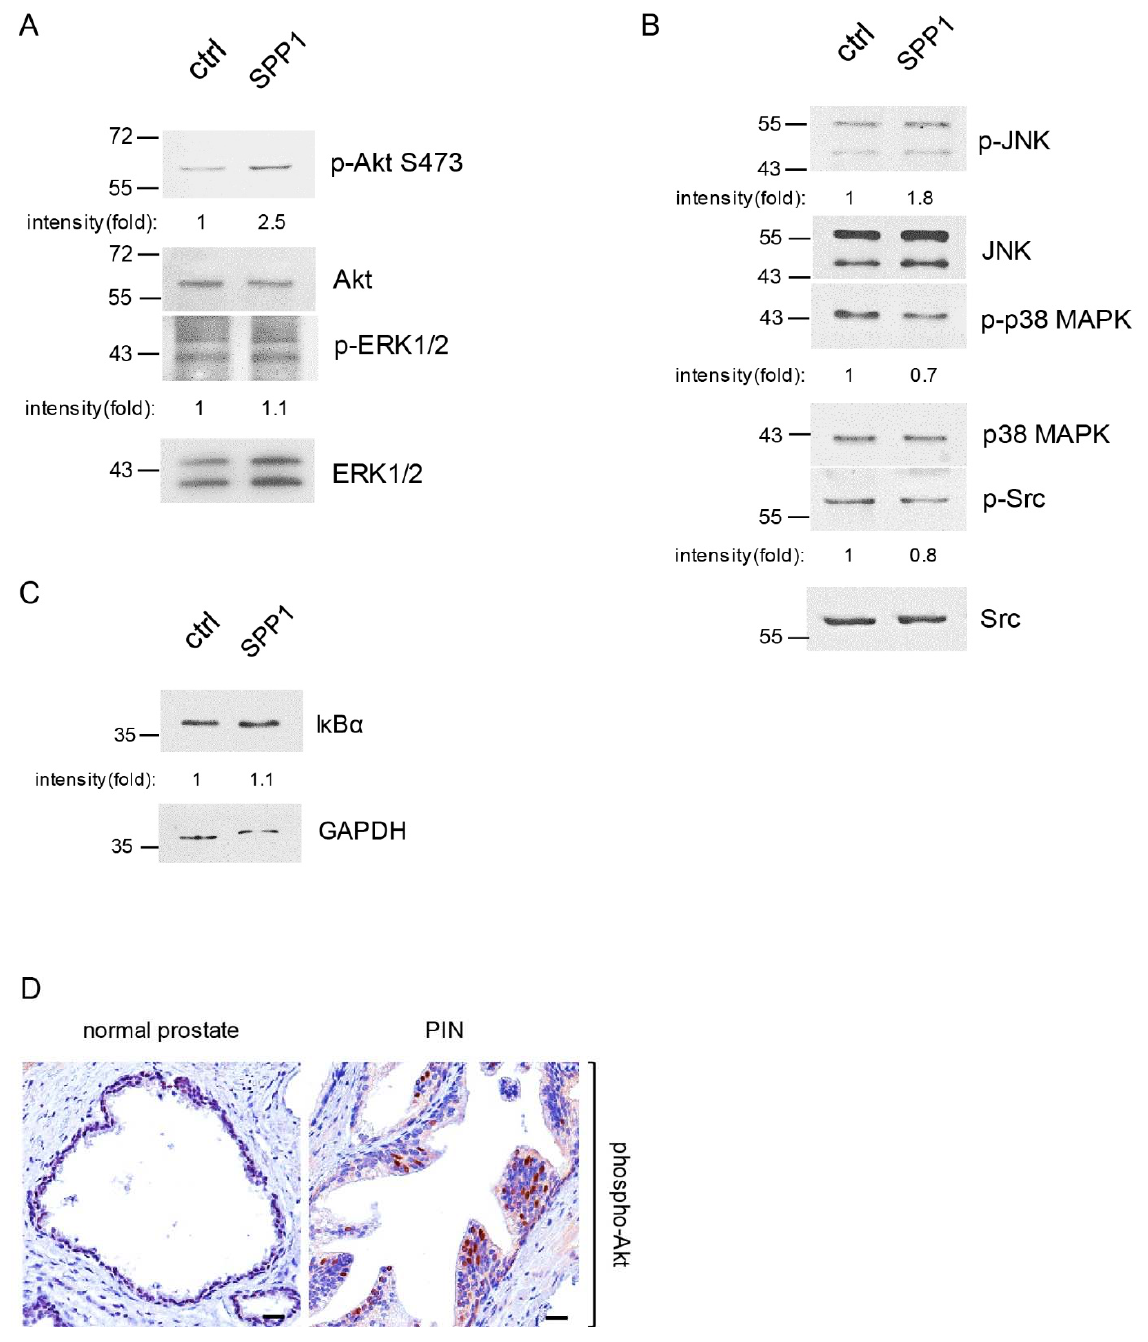
Figure 4. Macrophage Spp1 activated Akt and JNK signaling in PIN cells. ( A – C ) Pr111 cells cultured on Matrigel in 3D were stimulated with either control/ddH 2 O or recombinant Spp1 for 72 h. Cell lysates were collected and subjected to immunoblotting to examine the proteins of interest, including p ‐ Akt, Akt, p ‐ ERK, and ERK ( A ); p ‐ JNK, JNK, p38 MAPK, p38 MAPK, p ‐ Src, and Src ( B ); and I κ B α ( C ). The relative intensity fold change was calculated by the ratio of phosphorylated protein levels over the corresponding total protein levels and set as 1 for the control in each case. Each image shown is representative of 3–5 independent experiments. ( D ) Human tissue samples of normal prostate and prostate cancer containing PIN areas were immunostained for phospho ‐ Akt expression. Scale bar: 25 μ m. n = 3.